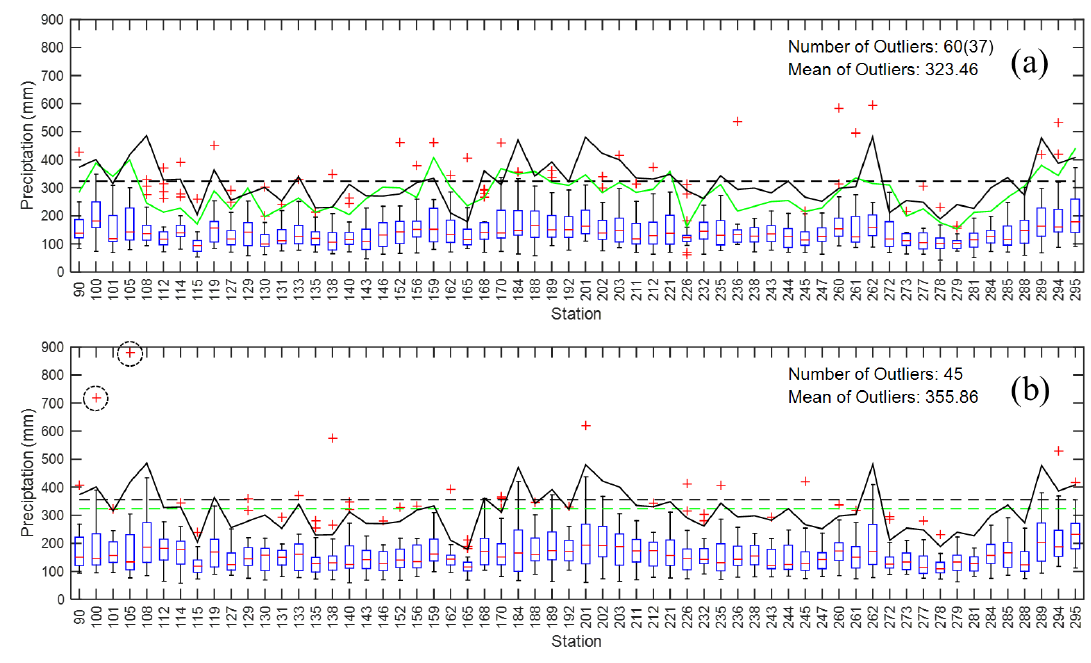
Figure 4. Boxplots for the annual maxima during: ( a ) 1974–1994; and ( b ) 1995–2014 for the 24-h duration; the grey dash shows the mean of the outliers during 1974–1994.